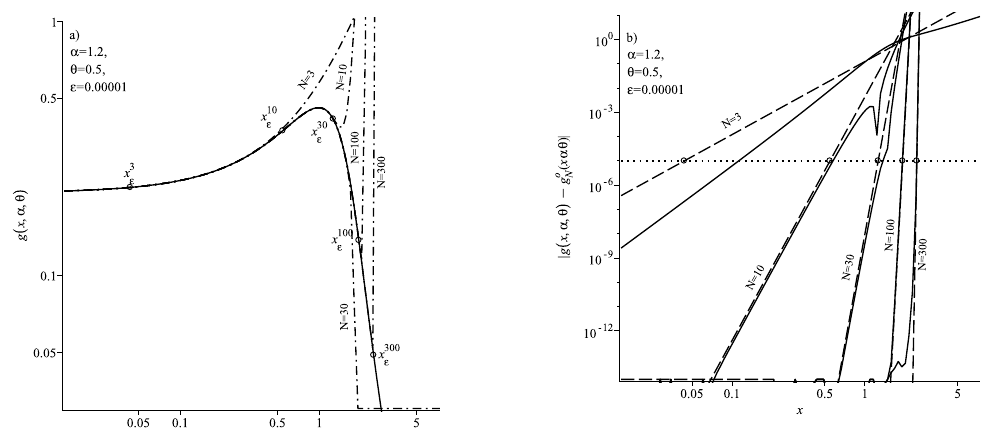
Figure 2. ( a ) Probability density g ( x , α , θ ) for the parameter values shown in the figure. A solid curve is the integral representation (3), dash-dotted curves are the series (12) for different values of the number of N summands in total. Circles are the position of the threshold coordinate (36) for each value of N . ( b ) The graph of the absolute error of calculating the probability density using a series (12) for the case given in Figure ( a ). Solid curves are the exact value of the absolute error | g ( x , α , θ ) − g 0 ( x , α , θ ) | , dashed curves are the estimate (13), and the dotted line shows the position N of the specified accuracy level ε . Circles demonstrate the location of the threshold coordinate (36) for the specified values of N